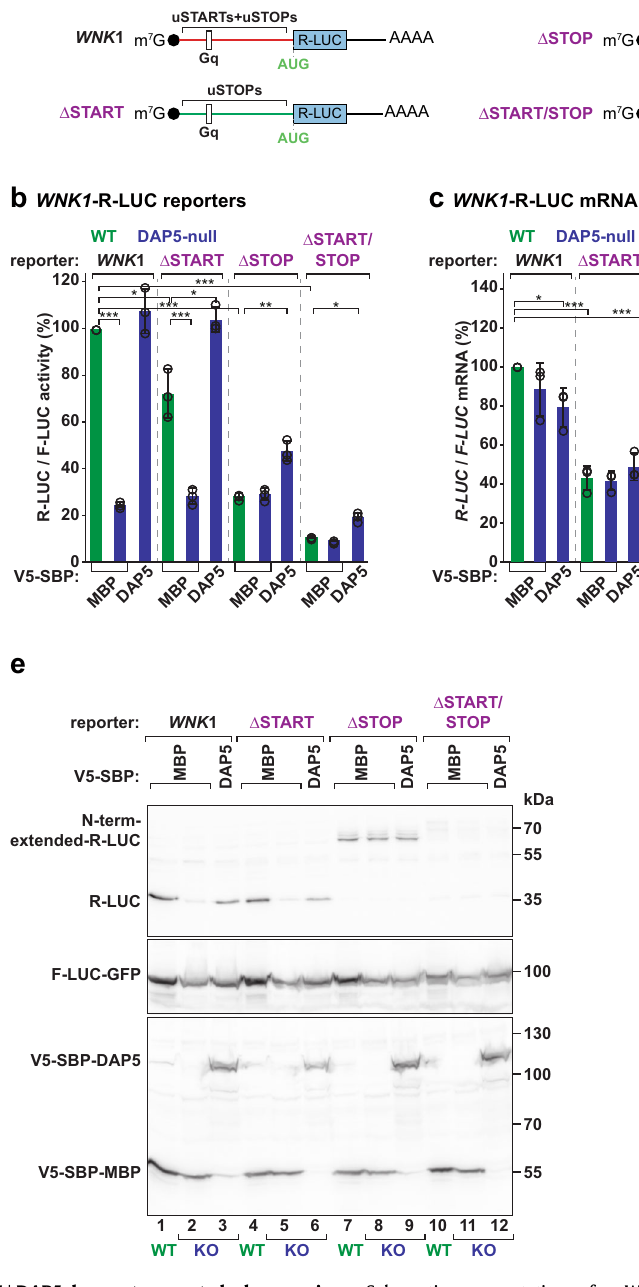
WT cells. Signi fi cance was determined by one-way ANOVA test and indicated sig- ni fi cant if p <0.05 (*), p <0.005 (**), and p <5e − 5 (***). Protein and mRNA ratios in WT and null cells are depicted in d . Bars show the mean value and error bars indicate the SD ( n =3 biologically independent experiments). The immunoblot in e shows the expression levels of the proteins used in the assay. Membranes were incubated with anti-V5, GFP, and R-LUC antibodies. Source data are provided as a Source Data fi